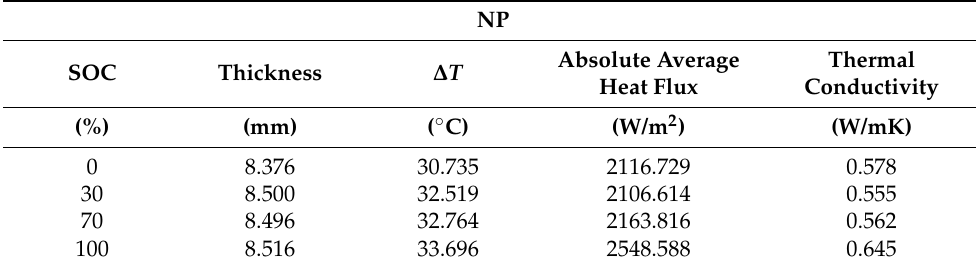
Table A4. Data used to calculate the thermal conductivity of cells aged without